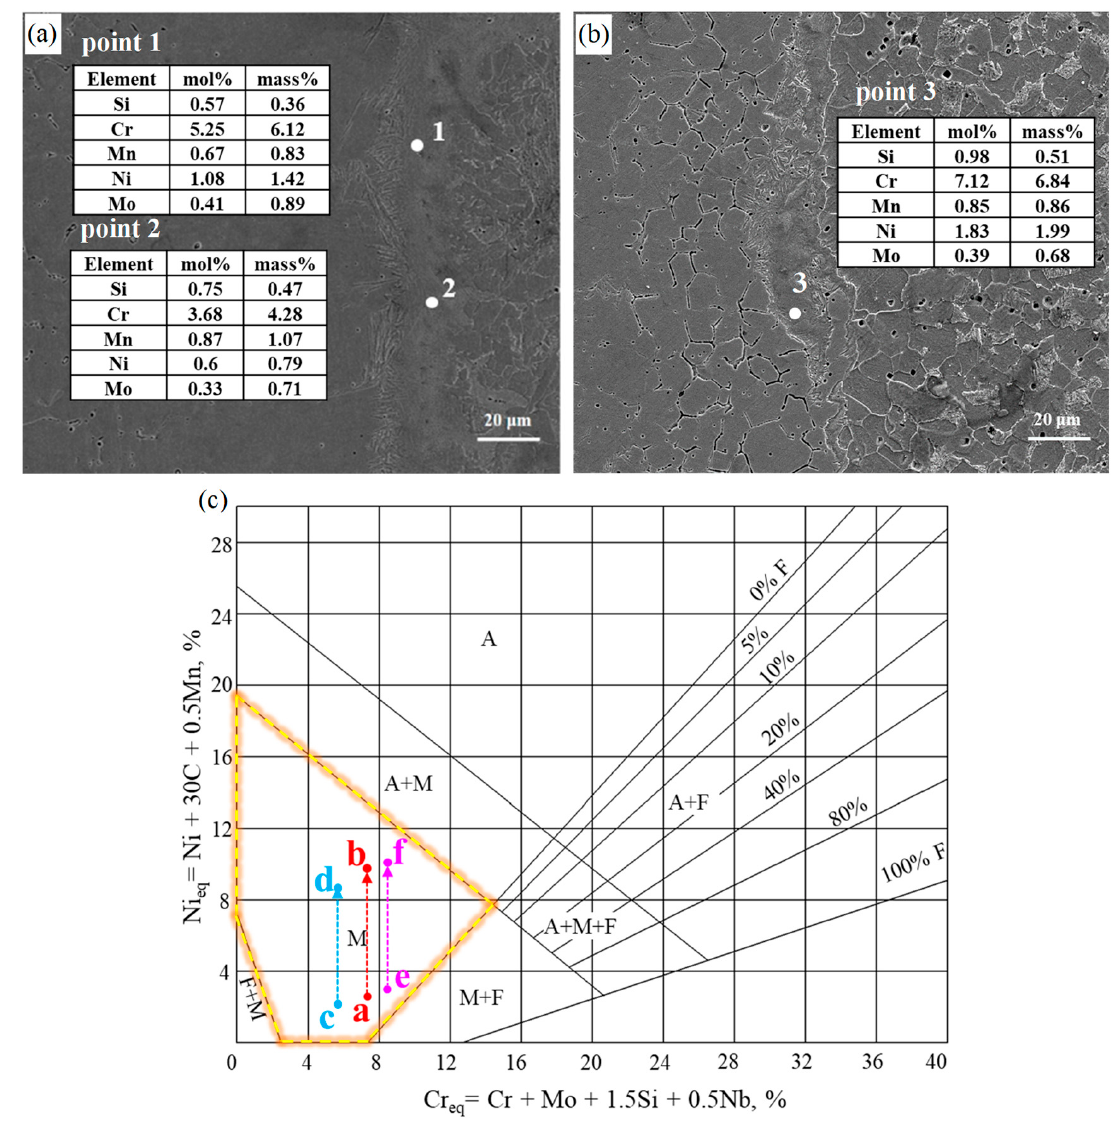
Figure 7. SEM image and Schaeffler diagram: ( a ) as deposited, ( b ) as rolled, ( c ) Schaeffler diagram relating to the equivalents of Cr and Ni.